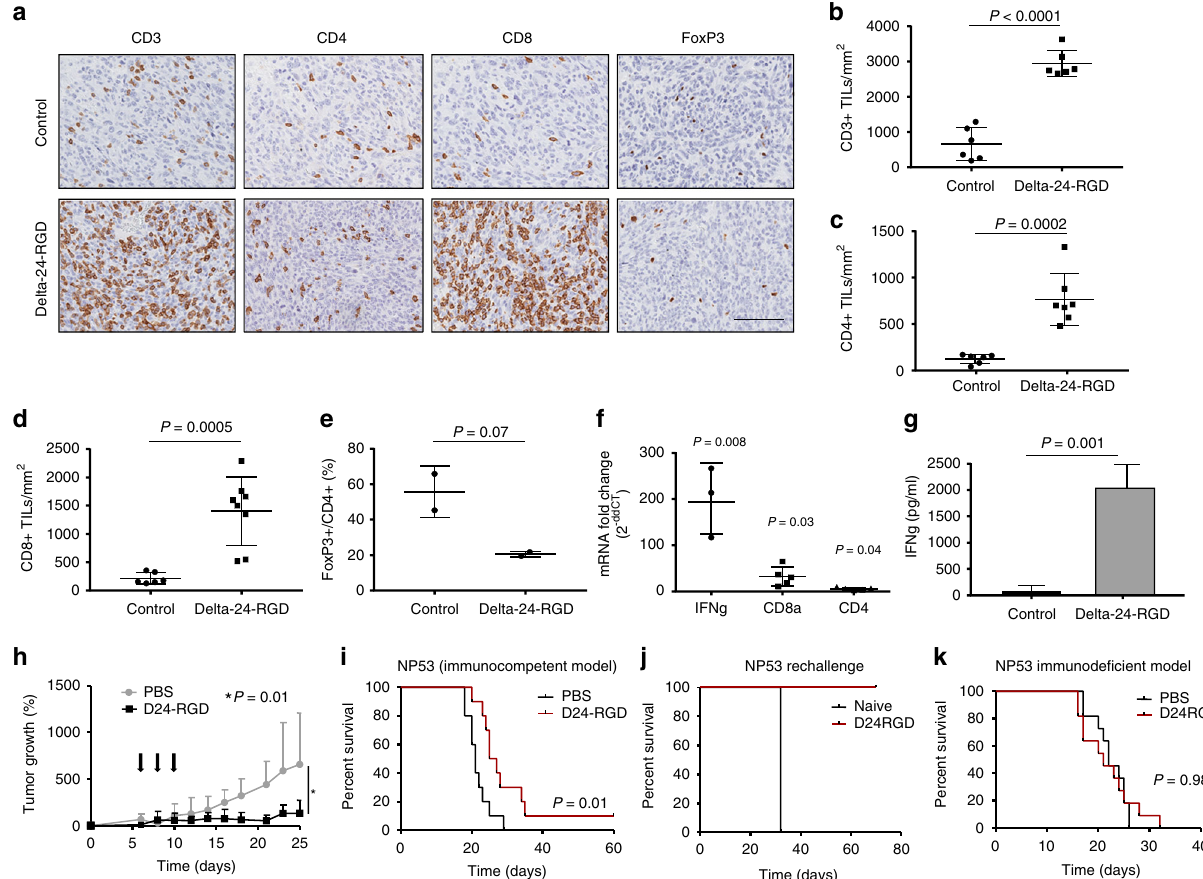
Fig. 5 Delta-24-RGD effect DIPG immunocompetent models. Brain tumors were developed by intracranial injection of the NP53 cell line, and PBS or Delta- 24-RGD were administered intratumorally 3 days after cell implantation and animals were killed at day15 after cell implantation ( a – h ). a Representative images (scale bar, 100 µ m) of CD3, CD4, CD8, and FoxP3 immunostaining of DIPG tumors from control mice or Delta-24-RGD-treated mice. b Quanti fi cation of positive CD3 + , c CD4 + , d CD8 + , and e FoxP3/CD4 + cell in fi ltration per mm 2 of DIPG tumors. Graph showing the quanti fi cation of positive cells in fi ltrating 15 days after cell implantation per mm 2 of PBS or Delta-24-RGD-treated tumors ( n = 3). P values were calculated using